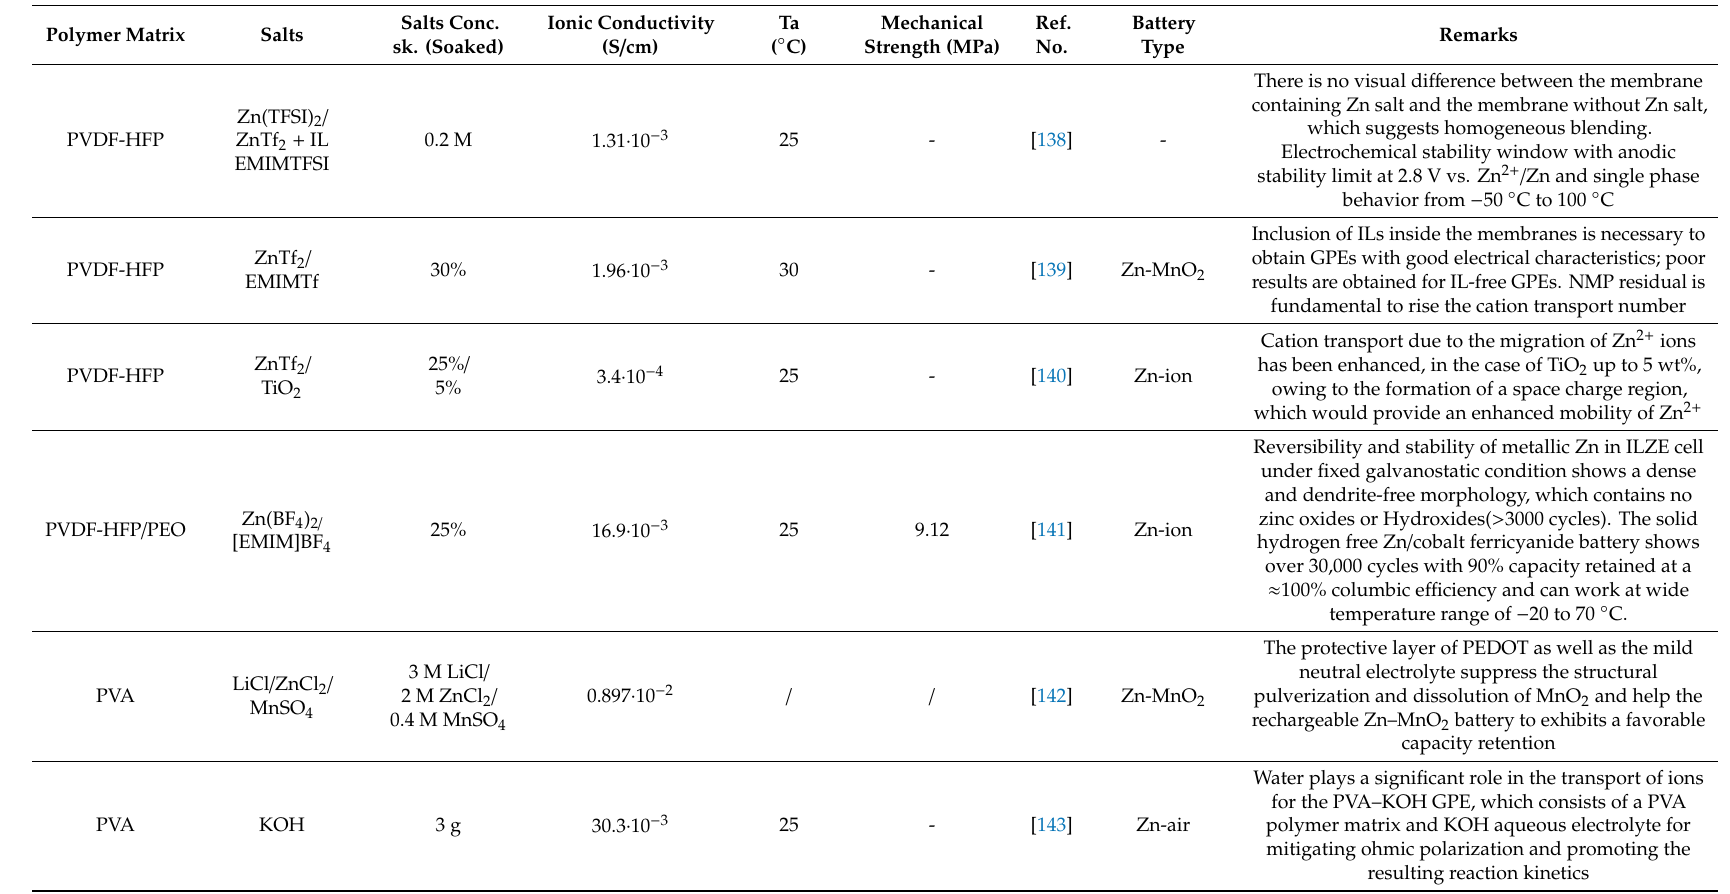
Table 3. Summary of GPEs systems mentioned in this